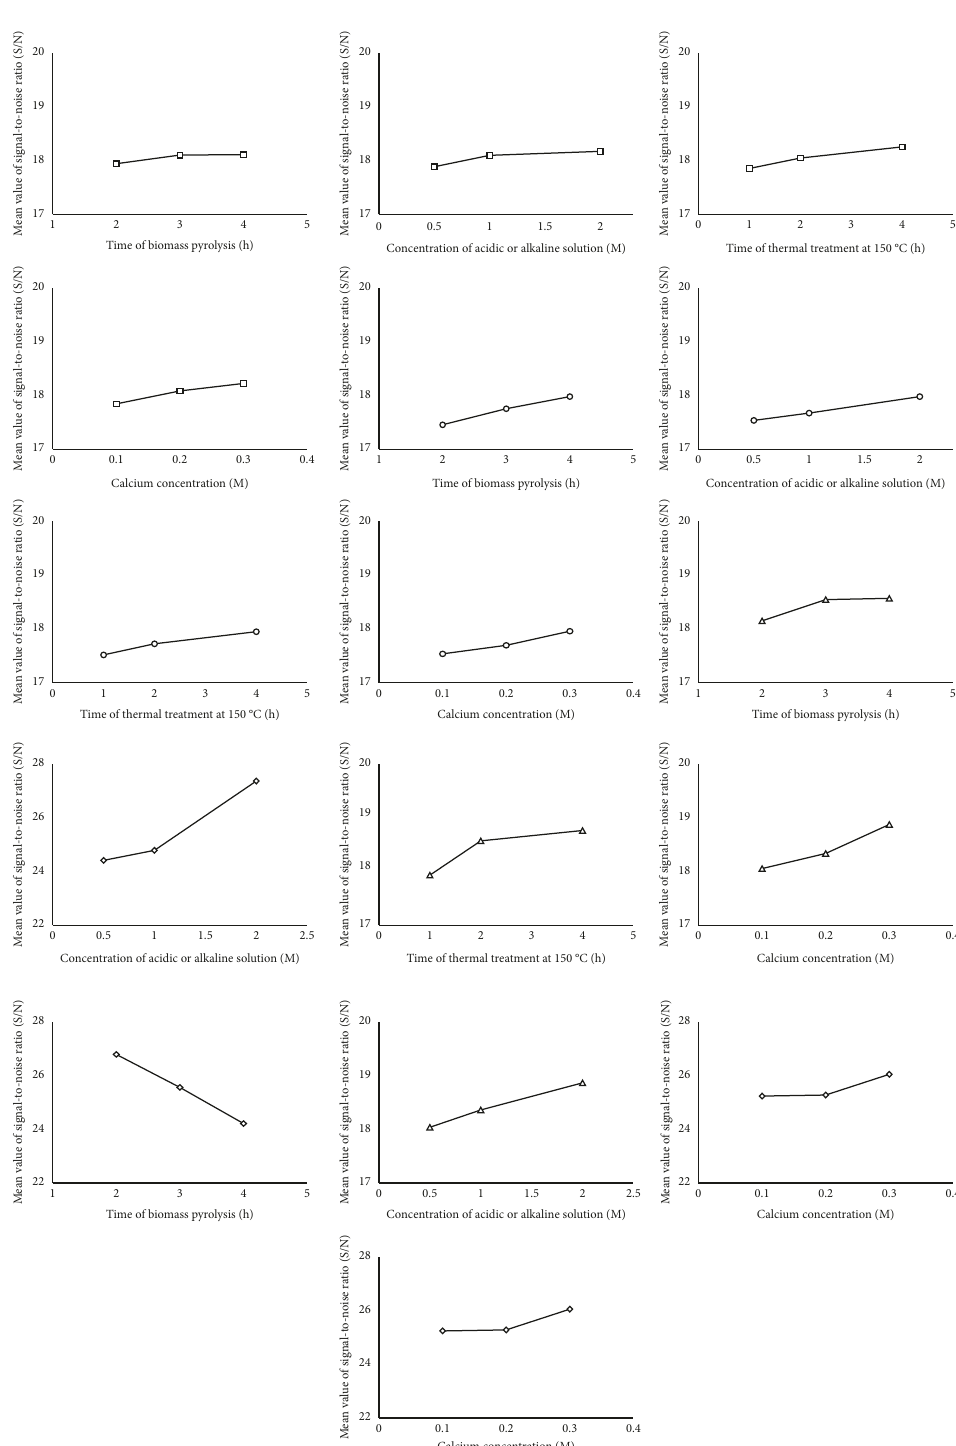
0.1 0.2 0.3 0.40 Calcium concentration